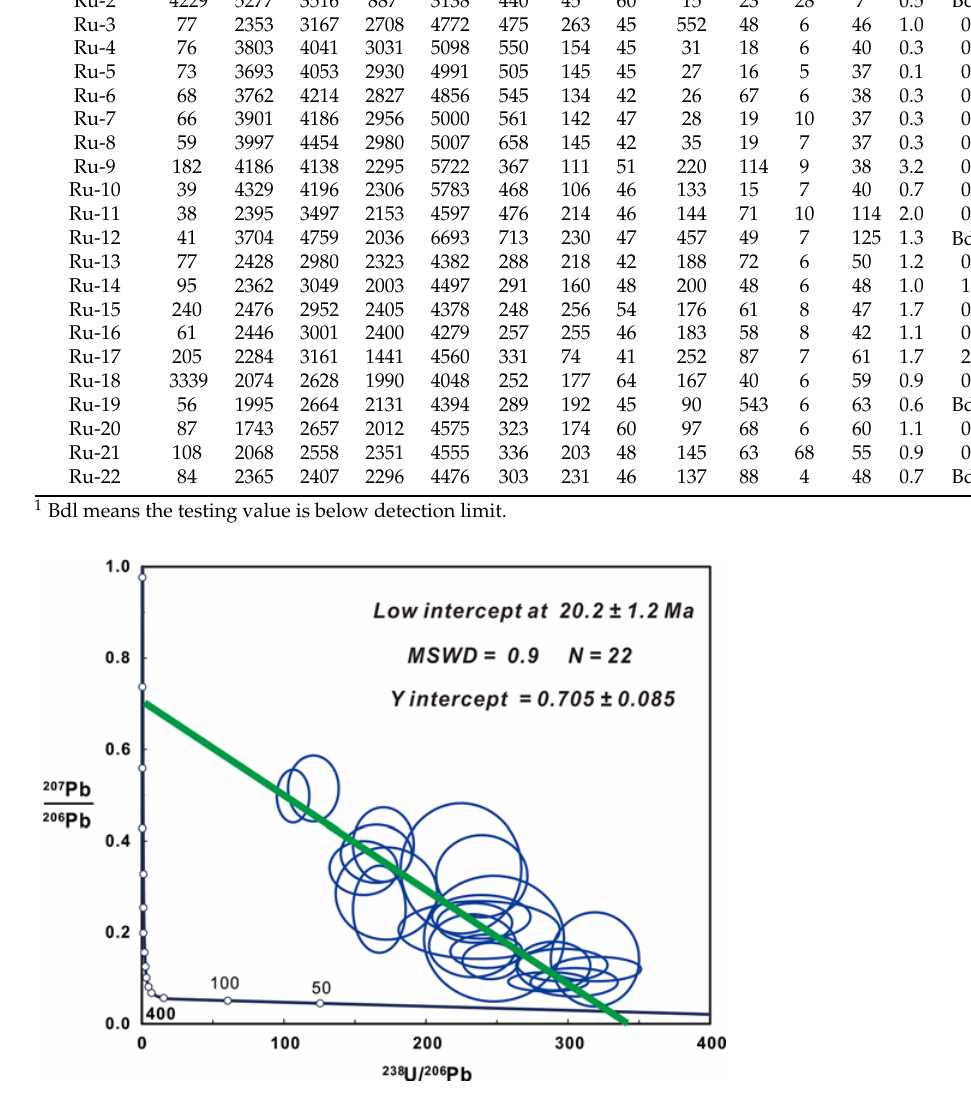
Figure 4. The Tera-Wasserburg plot of the uncorrected U–Pb data of rutile inclusions.